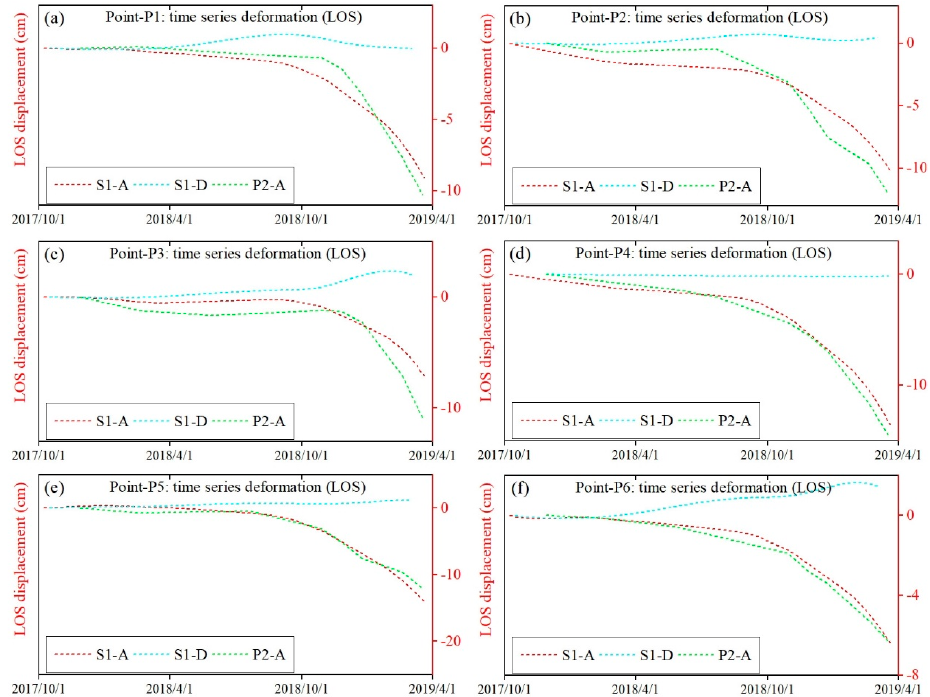
Figure 10. Time-series deformation of six monitoring points in the Xiaomojiu landslide. ( a – f ) time series deformation of six monitoring points marked in Figure 7a.